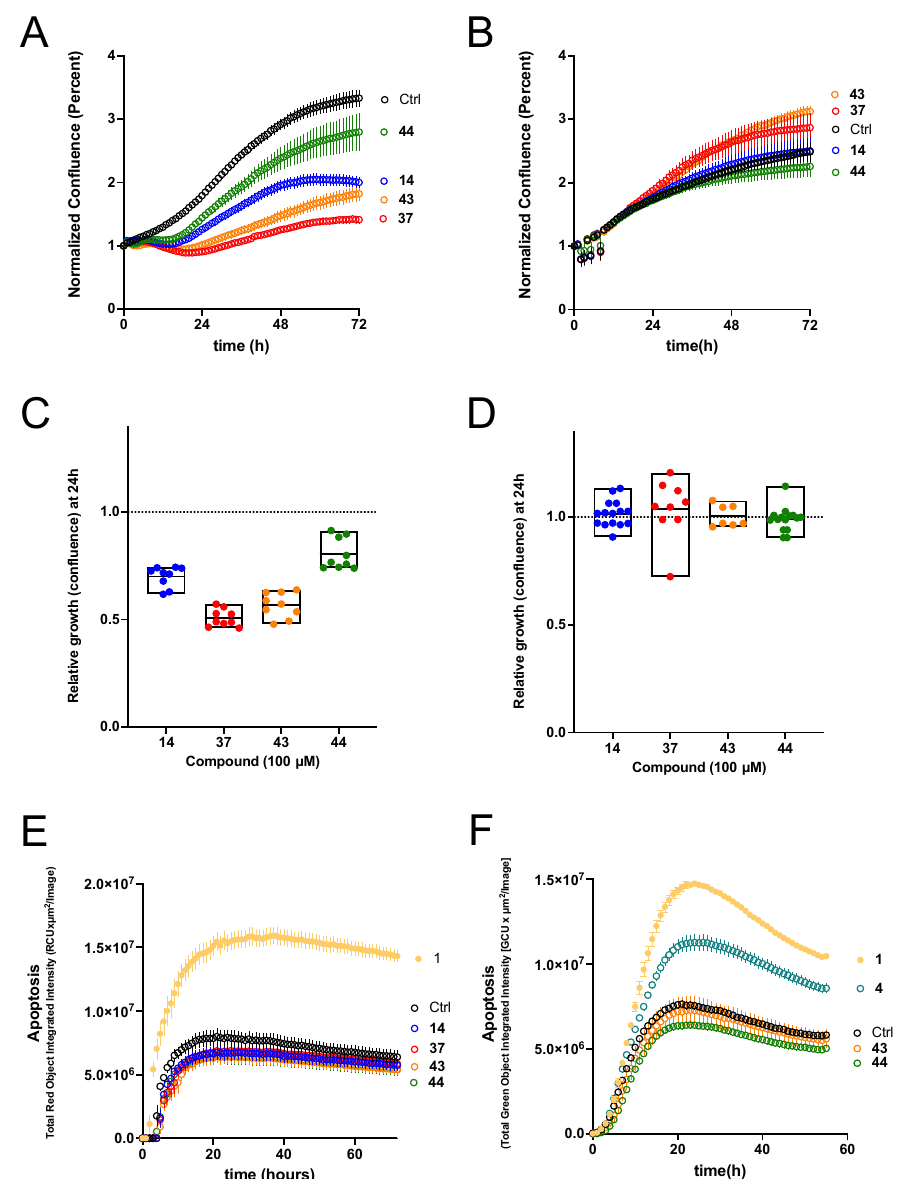
Figure 6. Effects on pancreatic cancer cell lines in 2D and 3D cell cultures. ( A ) Growth curves (culture confluence measured through phase contrast imaging) of Panc-1 cells in the presence of the indicated compounds (100 µM) or the vehicle (DMSO, black symbols). Mean ± S.E.M, N = 9. ( B ) The equivalent experiment on Colo-357 cells revealed that the growth inhibition was cell-type specific. Mean ± S.E.M, N = 15. The inhibition 24 h after the start of treatment is quantified in ( C , D ) for the data presented in ( A , B ) respectively. ( E ) Apoptosis measured as caspase 3/7 activity on Panc-1 tumor spheroids in the presence of the indicated compounds. ( F ) Apoptosis in Colo-357 tumor spheroids ( p < 0.001, Mean ± S.E.M, N = 4).